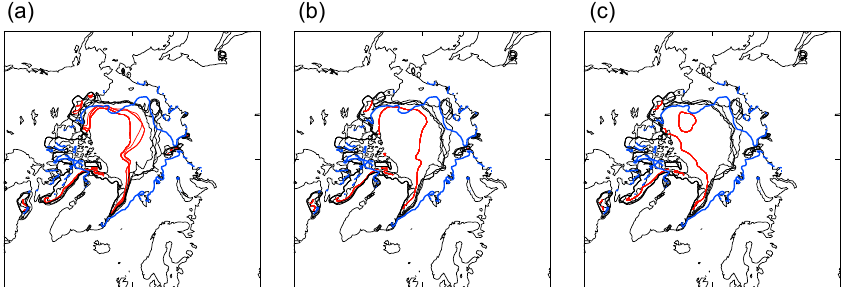
Figure 2. The spatial pattern of the sea ice edge (the 15% concentration contour) with the observation mean for the period 2006–2015 from HadISST (Rayner et al., 2003) in blue, the four-member model RCP ensemble for the equivalent period in black, and the 16-member ensemble simulations for the mean of years 2080–2099 in red. (a) The RCP2.6 simulations and Ensemble 1; (b) the RCP4.5 simulations and Ensemble 2; (c) the RPC4.5 simulations and Ensemble